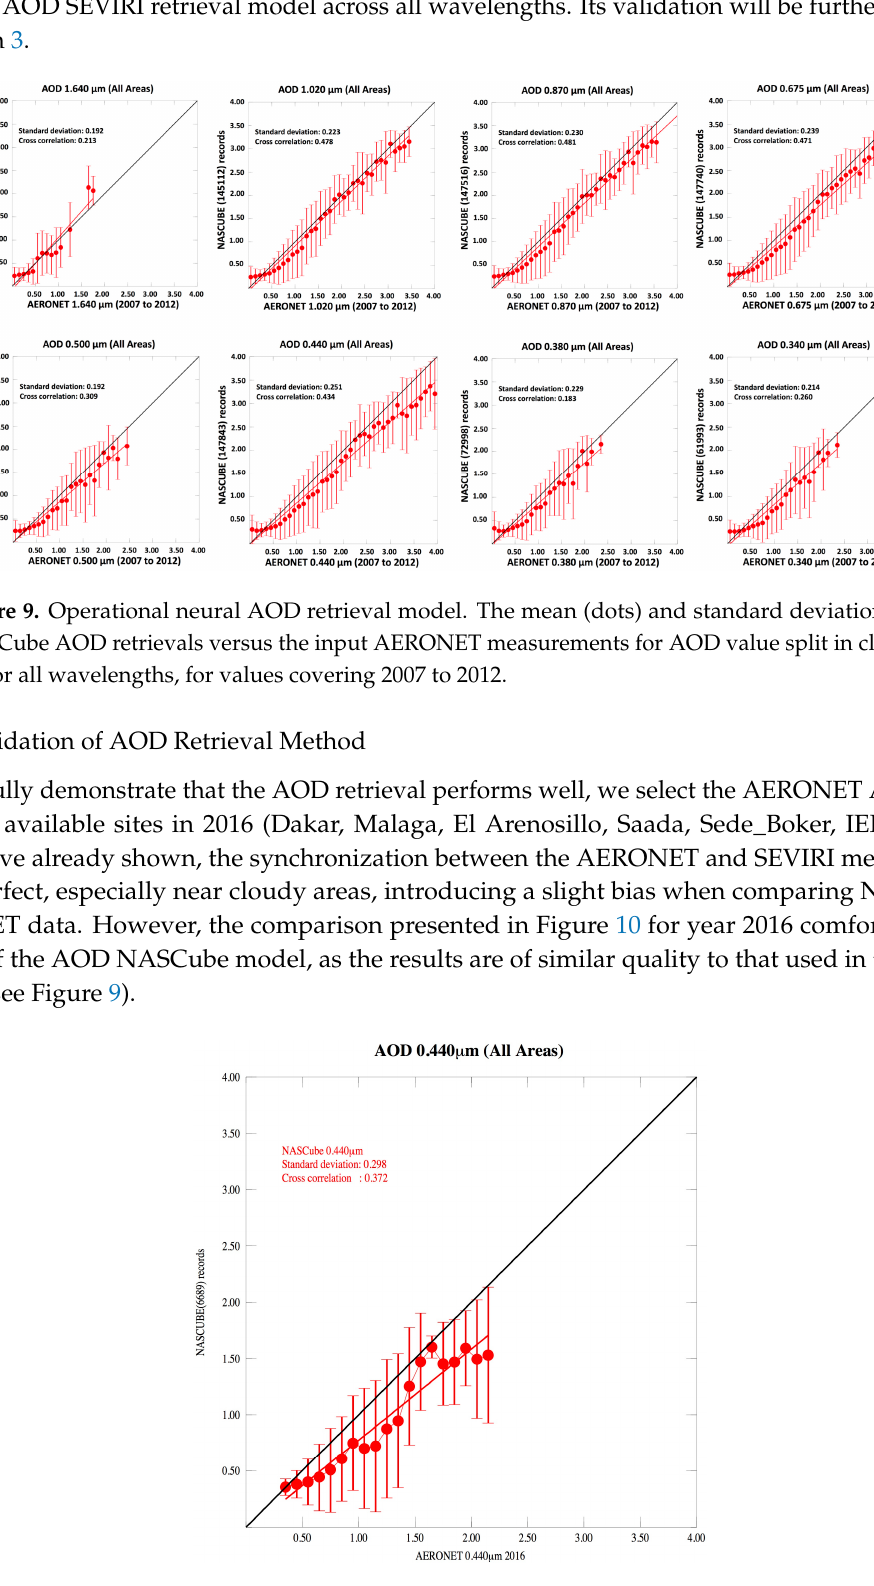
Figure 10. Comparison of AOD values obtained with NASCube retrieval model to AERONET ones for year 2016 at a wavelength of 0.44 µm. Mean (dots) and standard deviations are computed for AERONET AOD value classes of 0.1, excluding AOD values below 0.3.